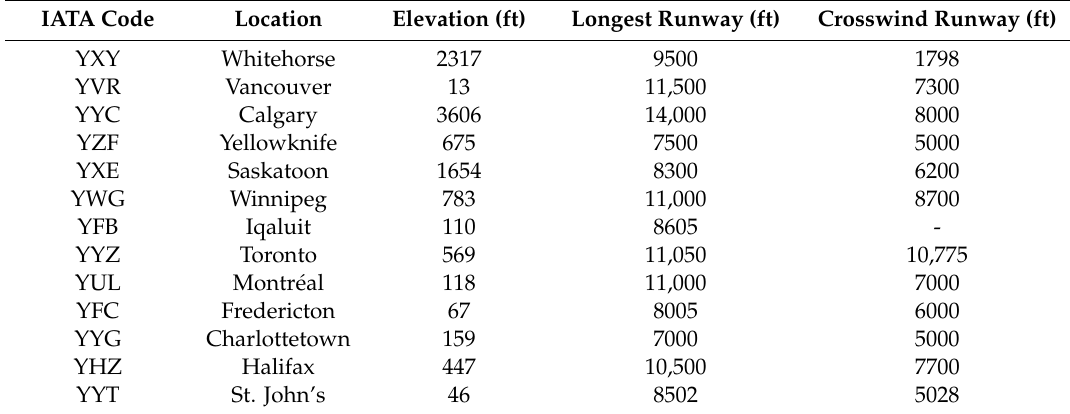
Table 1. Runway characteristics for the 13 Canadian airports considered in this study, along with the International Air Transport Association (IATA) code. Data obtained from Nav Canada airports chart. Primary runway length are for the longest runway at the airport; crosswind runways are also provided; and they are used during unfavorable conditions of the primary runway.